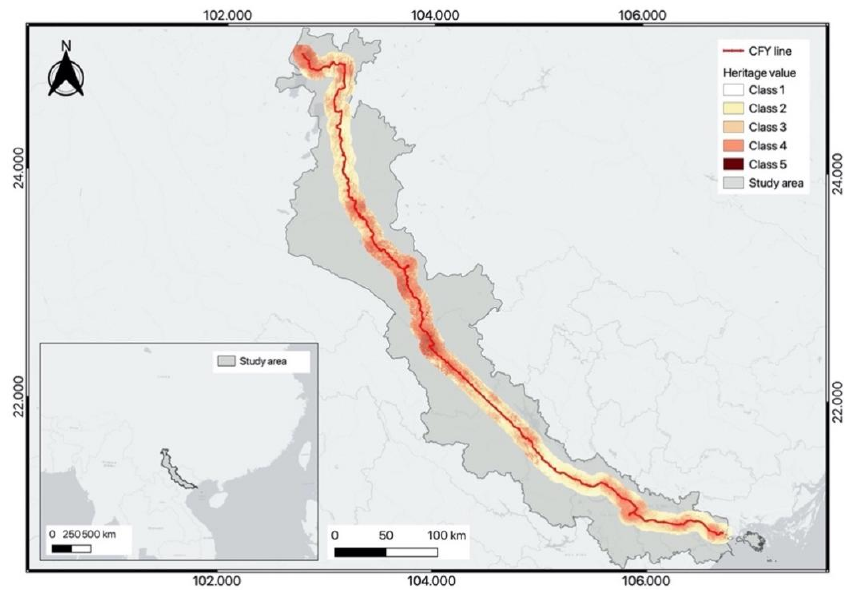
Figure 3. The result the landscape value. Class 1 means area with lower landscape value; class 2